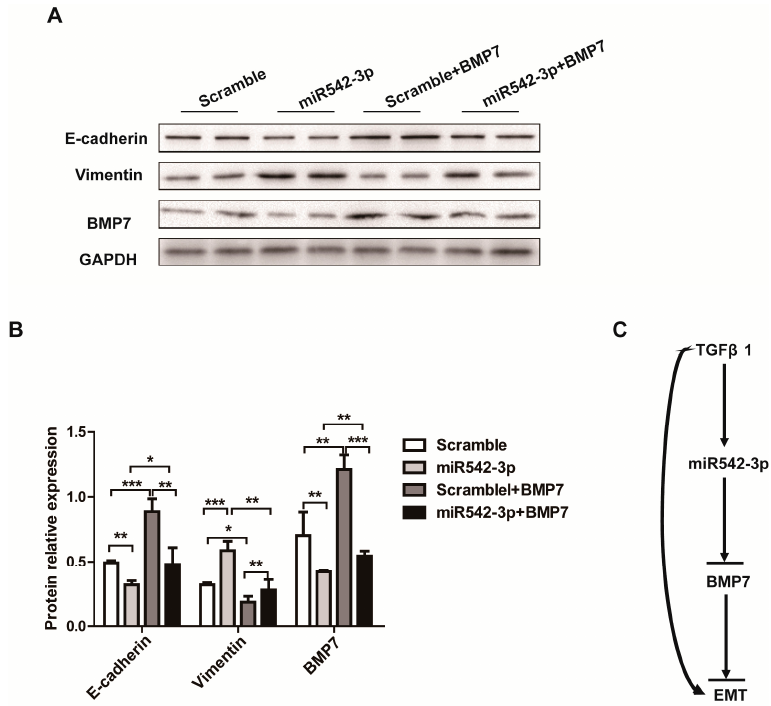
Figure 5. BMP7 attenuates the miR542-3p-induced EMT ( A ) Western blot results demonstrated that miR542-3p can suppress BMP7 protein expression and promote the Epithelial-Mesenchymal Transition (EMT) in the NRK52e cell line, however, the EMT was suppressed by the transiently transfected BMP7 expression vector (pCDNA3.1-BMP7); ( B ) Histogram showed the gray scale quantitative analysis for Western blot results. * p < 0.05, ** p < 0.01, *** p < 0.001; ( C ) The schematic diagrams of miR542-3p promoted Epithelial-Mesenchymal Transition (EMT).